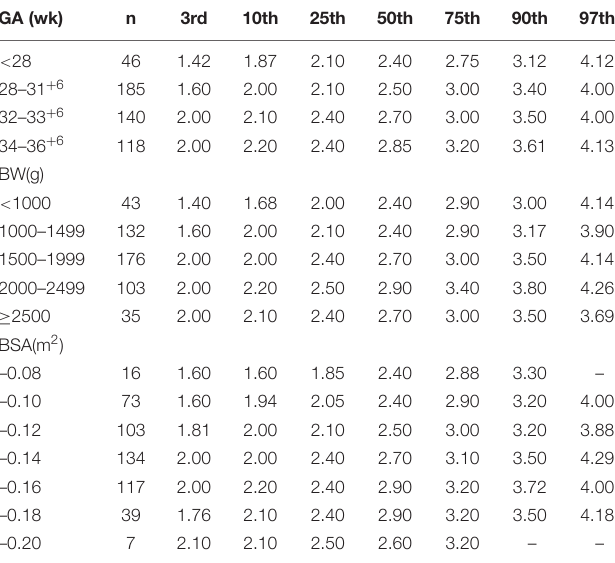
TABLE 6 | Left ventricular posterior wall end-diastolic thickness dimensions (mm) (from 3rd to 97th centiles) in relation to GA, BW, and BSA in preterm